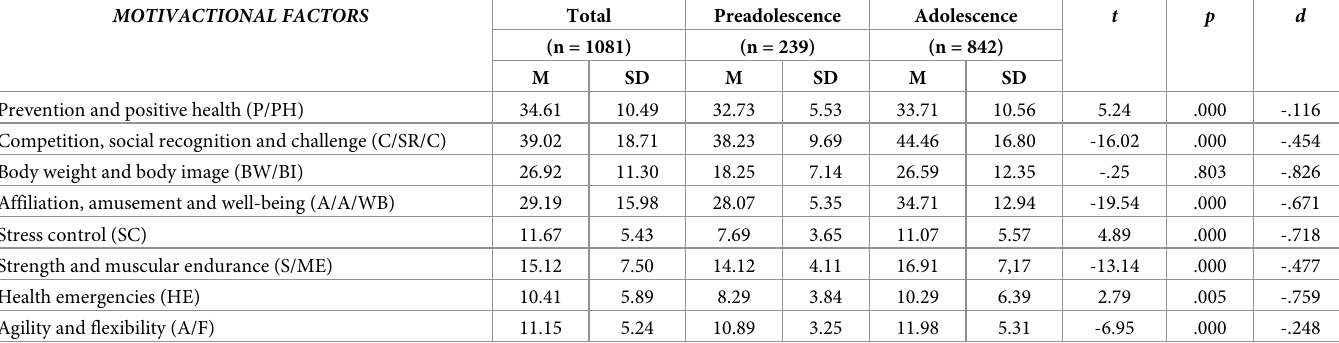
Table 1. Descriptive analysis and differences between preadolescents and adolescents in motivation towards the practice of physical activity. MOTIVACTIONAL